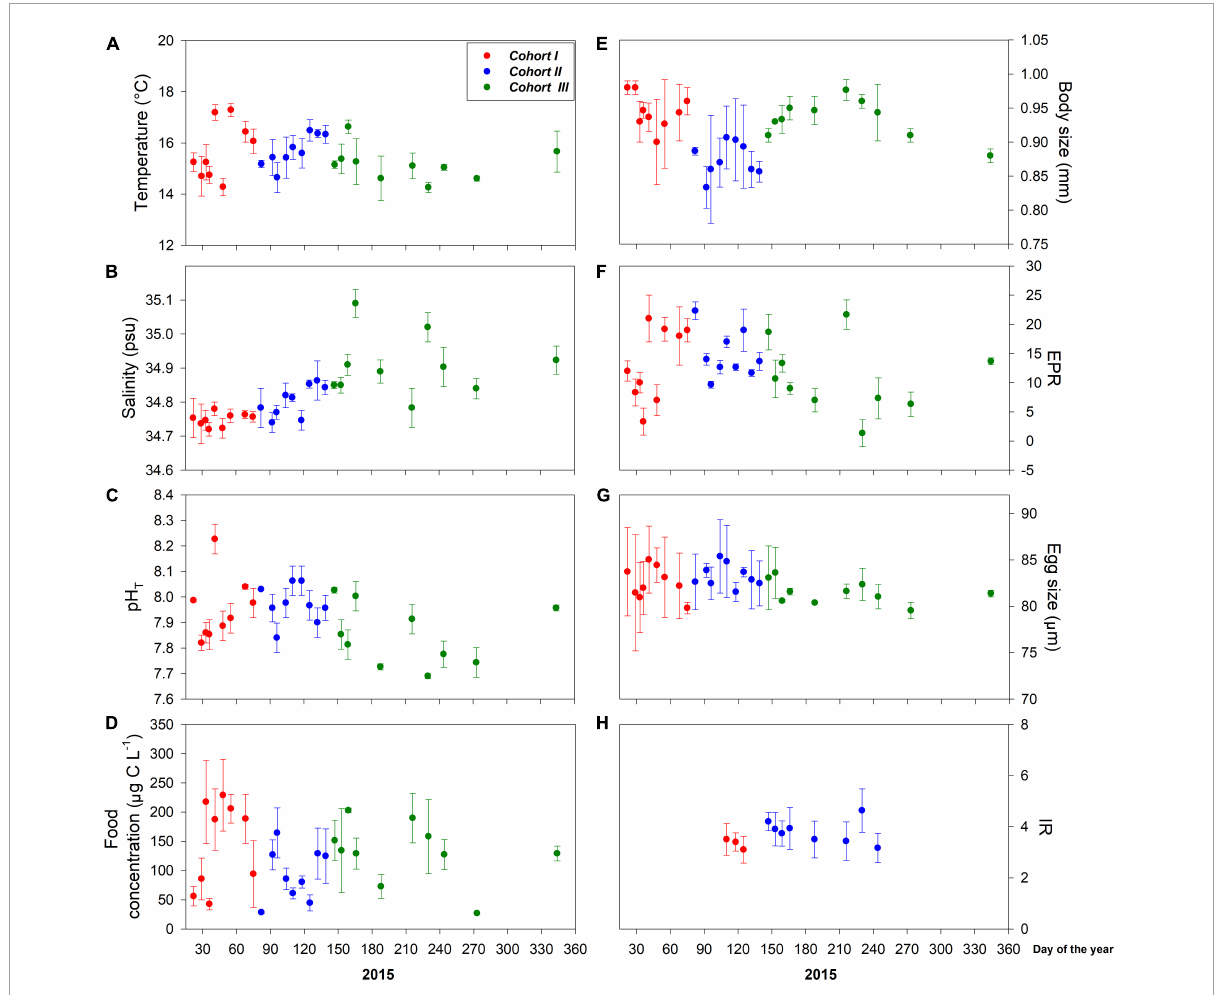
FIGURE2 Interdaily mean ( ± SD) values of environmental drivers (A–D) and copepod traits (E–H) assessed for three different cohorts at the upwelling habitat. Local A. tonsa population reproduces year-round under upwelling-dominant environmental conditions, which were strongly disrupted during samplings due to El Niño